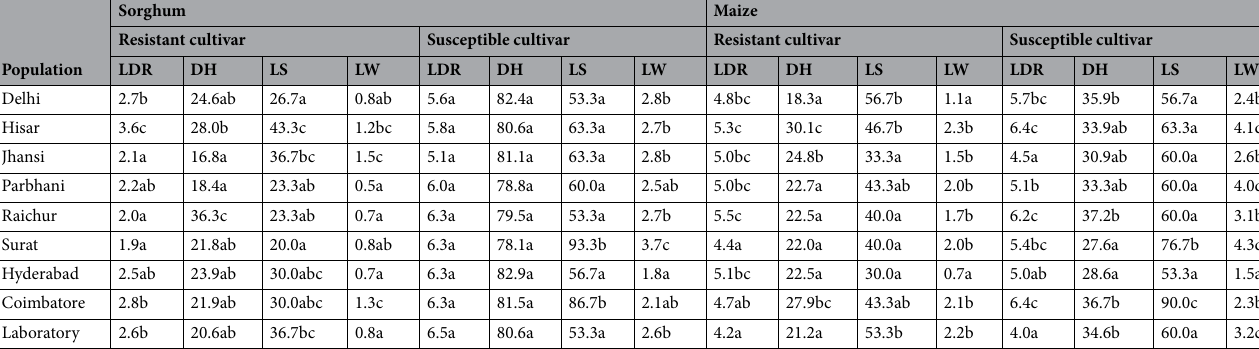
Leaf damage on the stem borer-susceptible sorghum genotype, Swarna varied significantly among C. partel- lus populations from different geographical regions (F 8,16 = 1.25; P = 0.334). However, there were no significant differences in deadhearts caused by C. partellus populations from different geographical regions. The Surat and Coimbatore populations showed better larval survival on Swarna as compared to the populations from other regions (F 8,16 = 10.30; P < 0.001). Chilo partellus larval weight was significantly greater (F 8,16 = 5.05; P = 0.003) in the Surat population as compared to populations from other geographical regions (Table 2). There were significant differences in leaf damage caused by C. partellus populations from different geographi- cal regions on the stem borer-resistant maize genotype, CPM 15. Larval development and survival also varied between C. partellus populations from different geographical regions. The Hisar and Raichur populations caused greater leaf damage (F 8,16 = 2.71; P = 0.043), while the Hisar and Coimbatore populations caused more dead- hearts (F 8,16 = 6.69; P < 0.001) as compared to the populations collected from other regions (Table 2). The larval survival was better in Delhi, Hisar, Parbhani, Coimbatore and laboratory populations (F 8,12 = 2.66; P = 0.046) as compared to the populations collected from other regions (Table 2). The larval weights were significantly greater (F 8,32 = 5.89; P = 0.001) in Delhi and Hyderabad populations as compared to populations collected from other geographical regions (Table 2). There were significant differences in leaf damage caused by different C. partellus populations on the stem borer-susceptible maize genotype, Basi Local. Larval development and survival also varied significantly across C. partellus populations from different geographical regions. The Jhansi, Hyderabad and laboratory populations caused lower leaf damage (F 8,16 = 7.09; P < 0.001), while the Surat and Hyderabad populations caused lower dead- hearts (F 8,16 = 3.37; P = 0.018) as compared to populations from other regions (Table 2). The Surat and Coimbatore populations showed better larval survival (F 8,12 = 3.89; P = 0.010) on the Basi Local maize genotype as compared to other populations (Table 2). Chilo partellus larval weights were significantly greater (F 8,32 = 15.89; P < 0.001) in the Hisar, Parbhani and Surat populations as compared to populations collected from other geographical regions (Table 2). Variation in lipophilic compounds in the larvae of different C. partellus populations. A total of 26 lipophilic compounds were detected in different C. partellus populations (Supplementary Fig. 1). There were significant differences in the amounts of different lipophilic compounds in the larvae of C. partellus popu- lations from different geographical regions in India (Table 3). The amounts of palmitoleic acid (F 8,16 = 279.55; P < 0.001), palmitic acid (F 8,16 = 86.87; P < 0.001) and oleic acid (F 8,16 = 16.96; P < 0.001) were significantly lower, while those of n-pentadecanol (F 8,16 = 12.72; P < 0.001), 1-octadecanol (F 8,16 = 17.28; P < 0.001), 1-nonadecene (F 8,16 = 33.39; P < 0.001), margaric acid (F 8,16 = 254.52; P < 0.001), 9-octadecen-1-ol (F 8,16 = 28.54; P < 0.001), methyl 11-eicosenoate (F 8,16 = 12.99; P < 0.001), eicosanoic acid (F 8,16 = 5.75; P = 0.001), 1,16-hexadecanediol (F 8,16 = 41.50; P < 0.001), erucic acid (F 8,16 = 12.61; P < 0.001), (Z)-14-tricosenyl formate (F 8,16 = 3.19; P = 0.003), squalene (F 8,16 = 35.49; P < 0.001), 1-triacontanol (F 8,16 = 3.22; P = 0.002), cholesterol (F 8,16 = 113.71; P < 0.001), gamma-ergostenol (F 8,16 = 3.32; P = 0.020), chondrillasterol (F 8,16 = 3.03; P = 0.008) and lathosterol (F 8,16 = 8.57; P < 0.001) were significantly greater in the larvae of Hisar and laboratory populations (except eicosanoic acid) as compared to the populations collected from other geographical regions (Table 3). Greater amount of palmitoleic acid (F 8,16 = 279.55; P < 0.001) was recorded in the Delhi population, while the amounts of methyl 3-methxy- tetradecanoate (F 8,16 = 15.67; P < 0.001), methyl 14-methxyhexadecanoate (F 8,16 = 3.25; P = 0.021), linoleic acid (F 8,16 = 14.39; P < 0.001) and oleic acid were greater in Parbhani population; l-(+)-ascorbic acid 2,6-dihexade- canoate (F 8,16 = 128.15; P < 0.001) in Raichur and Coimbatore populations; stearic acid in Surat population; and myristic acid (F 8,16 = 53.66; P < 0.001) and stearic acid (F 8,16 = 14.32; P < 0.001) in Hyderabad population as com- pared to C. partellus populations from other geographical regions (Table 3). However, the amount of methyl 16-methyl-heptadecanoate (F 8,16 = 5.86; P = 0.001) was significantly lower in the Surat and Hyderabad popula- tions as compared to other geographical C. partellus populations (Table 3).